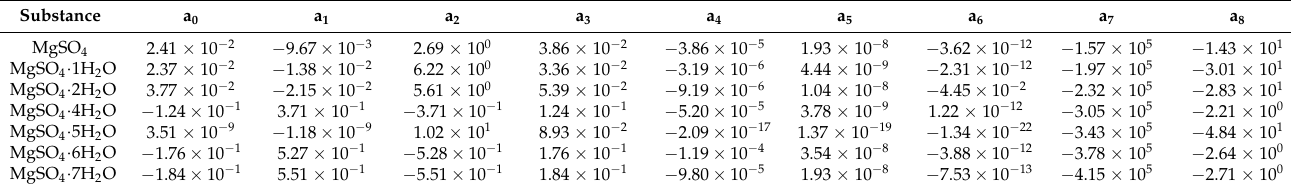
Table 10. Calculated NASA9 parameters through the CMA-ES method.